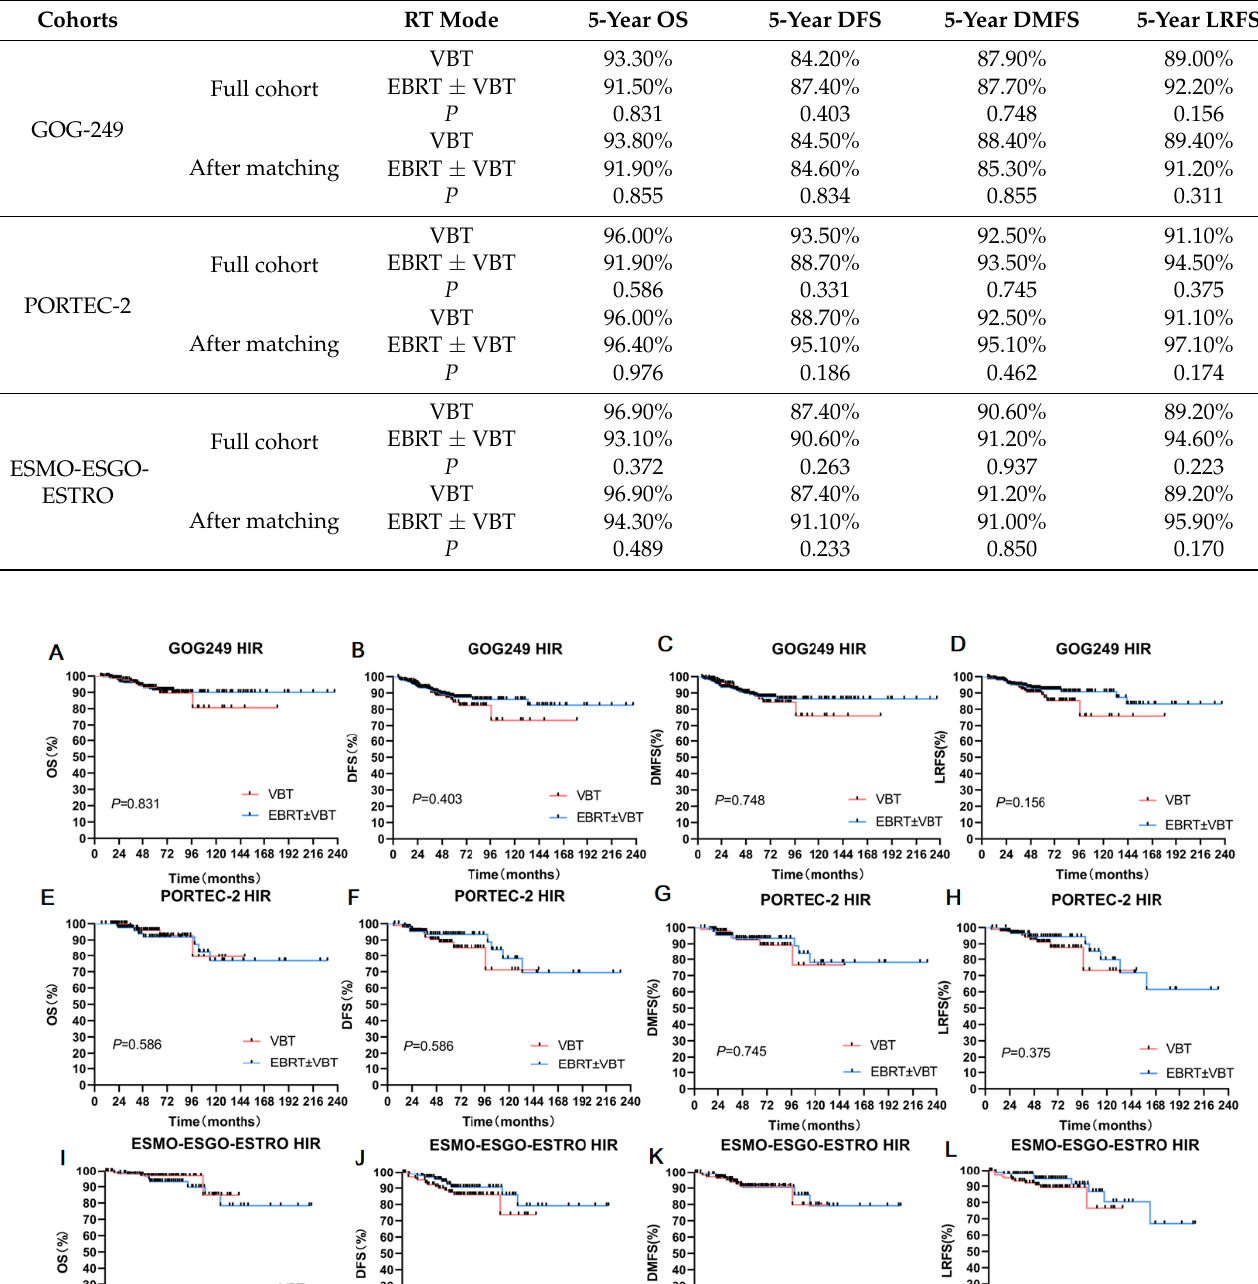
Table 2. Survival analysis for patients who received VBT or EBRT ± VBT in the three HIR groups.